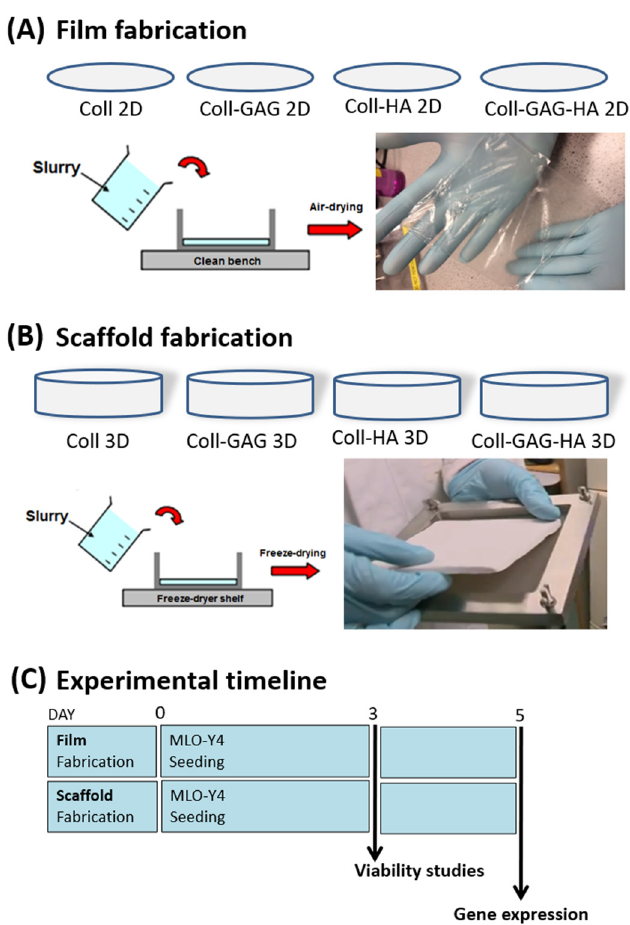
Figure 1. Experimental design. Slurries of four different compositions were produced: Collagen-1 (Coll), Collagen-1 + Chondroitin Sulphate (Coll-GAG), Collagen-1 + Hydroxyapatite (Coll-HA), Collagen-1 + Chondroitin Sulphate + Hydroxyapatite (Coll-GAG-HA). ( A ) 2D films were produced by allowing slurries to air dry upon a clean bench. ( B ) 3D scaffolds were fabricated by freeze drying slurry preparations. ( C ) Experimental timeline whereby all ECM analogues were seeded. After 3 days culture samples were analysed for viability assays. After 5 days seeded ECM analogues were analysed for differential gene expression between each composition groups, and between 2D and 3D culture groups.